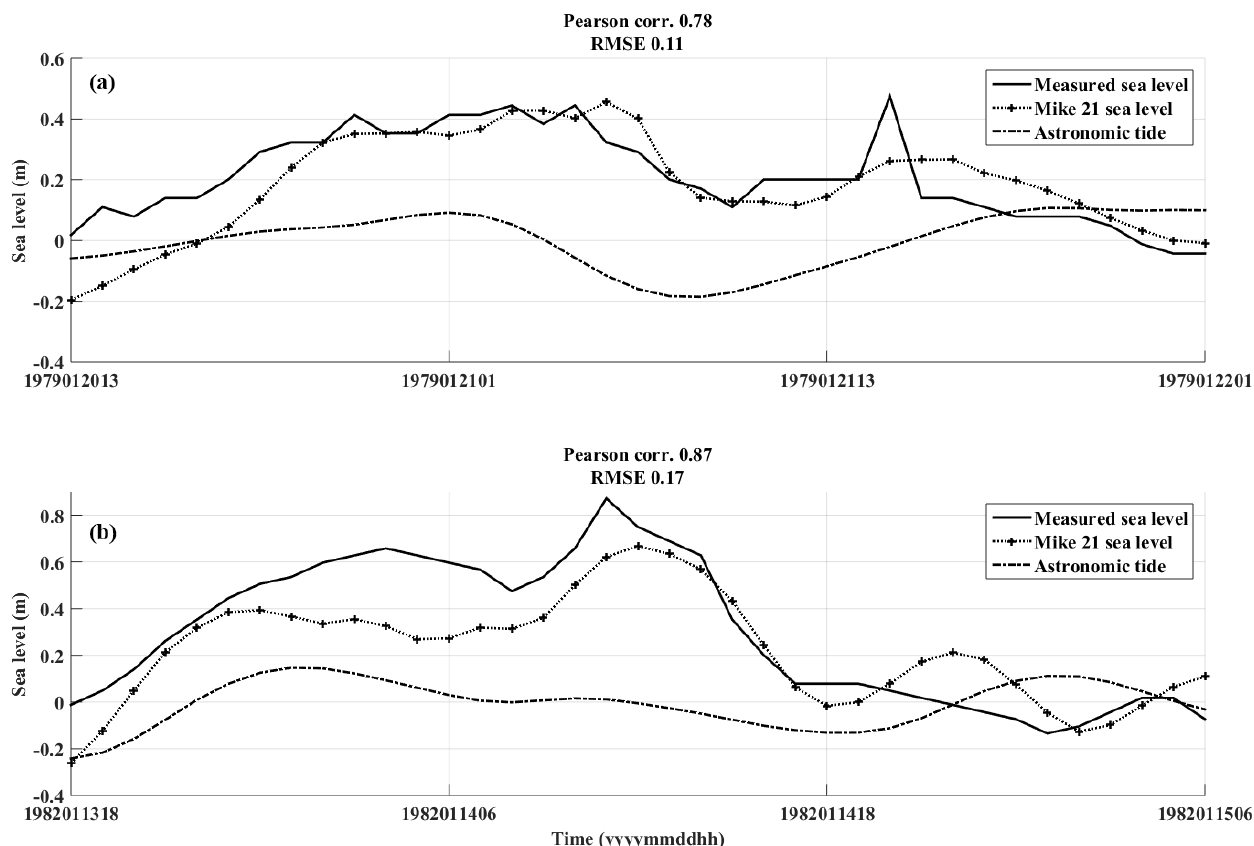
Figure 5. Hydrodynamic model validation with tide gauge data from Progreso port in Yucatán. (a) Validation for a CACS event in 1979. (b) Validation for a CACS event in